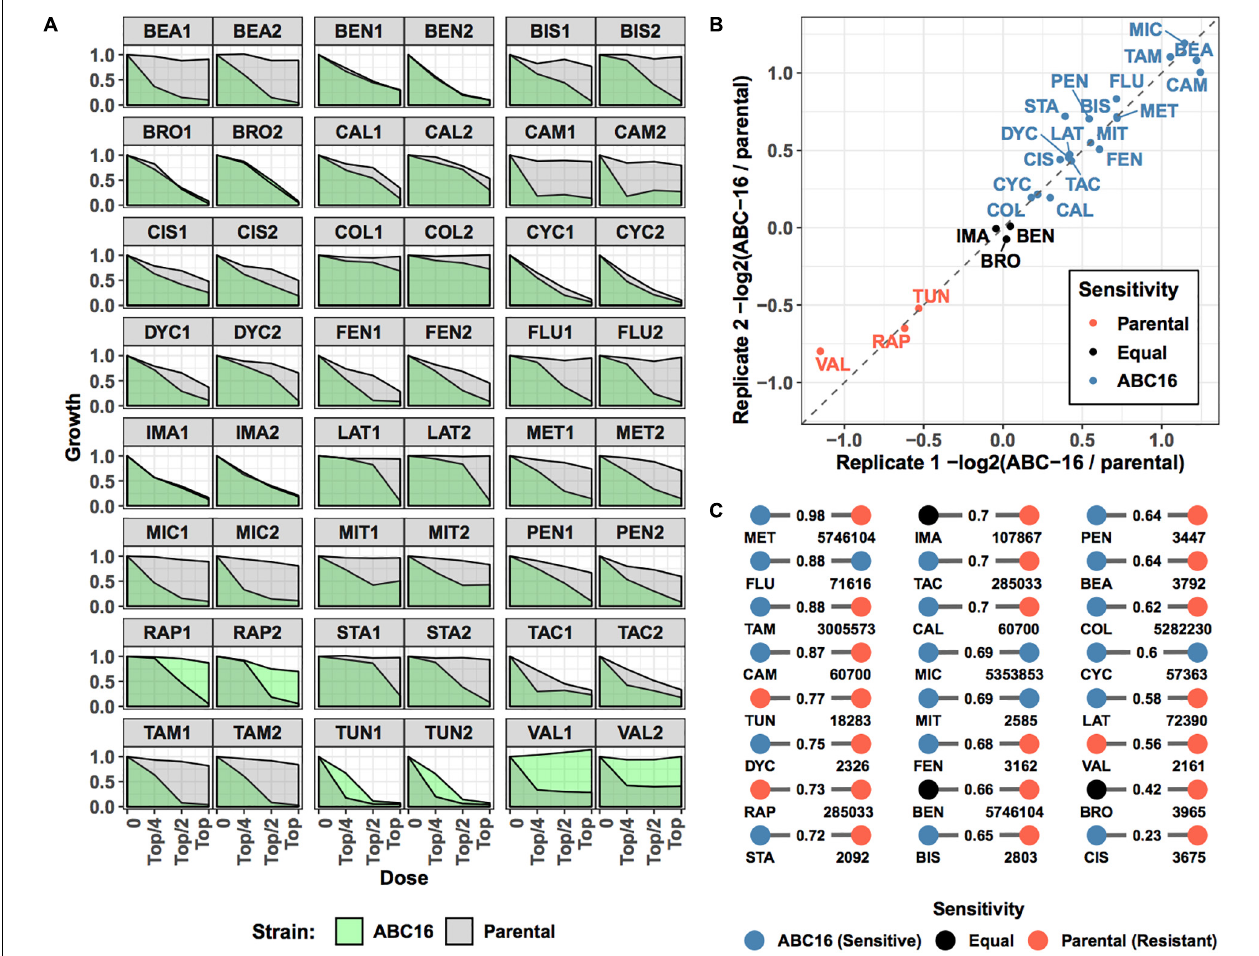
FIGURE 4 | Overview of prospective validation dataset. Three-letter abbreviations for each drug are given in Table 2 . (A) For 24 new drugs, dose-response experiments were carried out for parental and ABC-16 yeast strains, in duplicate. The drug doses in each experiment are two-fold dilutions starting from a top concentration shown in Table 2 . Dose-responses for ABC-16 or parental yeast strains are shown in green and gray, respectively. (B) For each experiment, relative efficacy against the ABC-16 yeast is calculated by taking the –log2 of the ratio of the area under dose-response for ABC-16 yeast with the area under the dose-response of the parental strain. This score is zero if ABC-16 and parental yeast strains are equally sensitive. The score is negative or positive if ABC-16 yeast is more resistant or sensitive, respectively. As shown, the relative efficacy scores for the two replicates are highly concordant. The drugs with less, equal or more efficacy to ABC-16 compared to wild type yeast are shown in orange, black or blue, respectively. (C) Tanimoto similarity between prospective validation and training datasets, presented as a bipartite graph. For each drug in the prospective validation set (left nodes), we identified its closest neighbor in the training set (right nodes, annotated with PubChem IDs). Nodes are colored according to relative efficacy against ABC-16 yeast with Tanimoto similarity scores displayed as edge